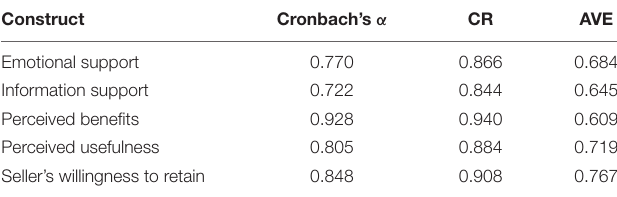
TABLE 3 | Reliability and convergent validity.